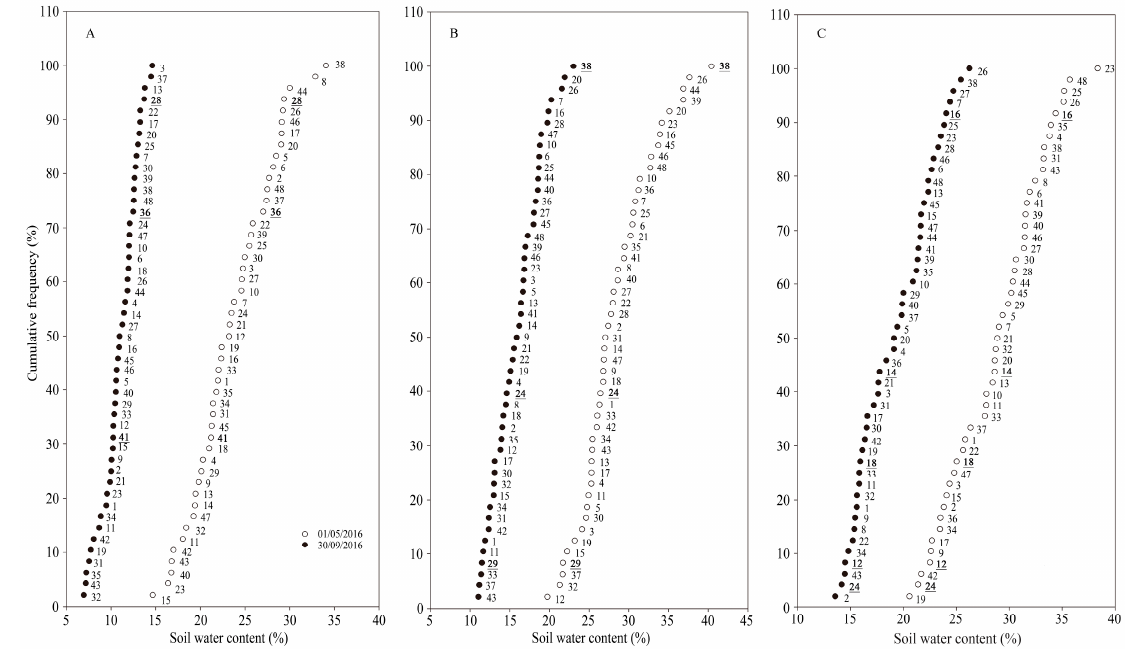
Figure 6. The cumulative frequency of 48 points at the two days with maximum and minimum VSM in the soil layers of 0–20 cm ( A ), 20–40 cm ( B ), and 40–60 cm ( C ).